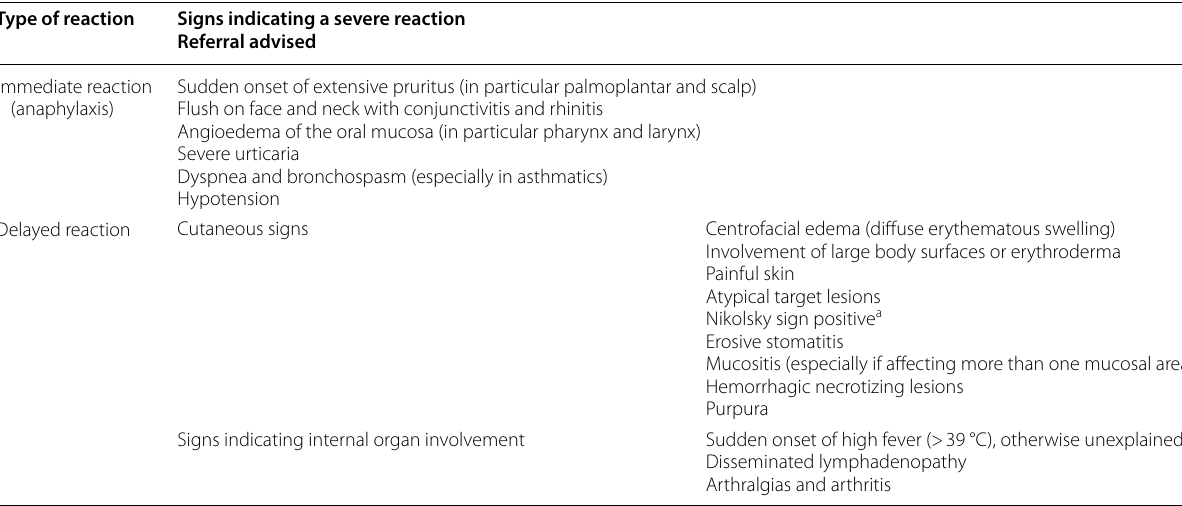
Table 2 Signs indicating the possible severe progression of a DHR Type of reaction